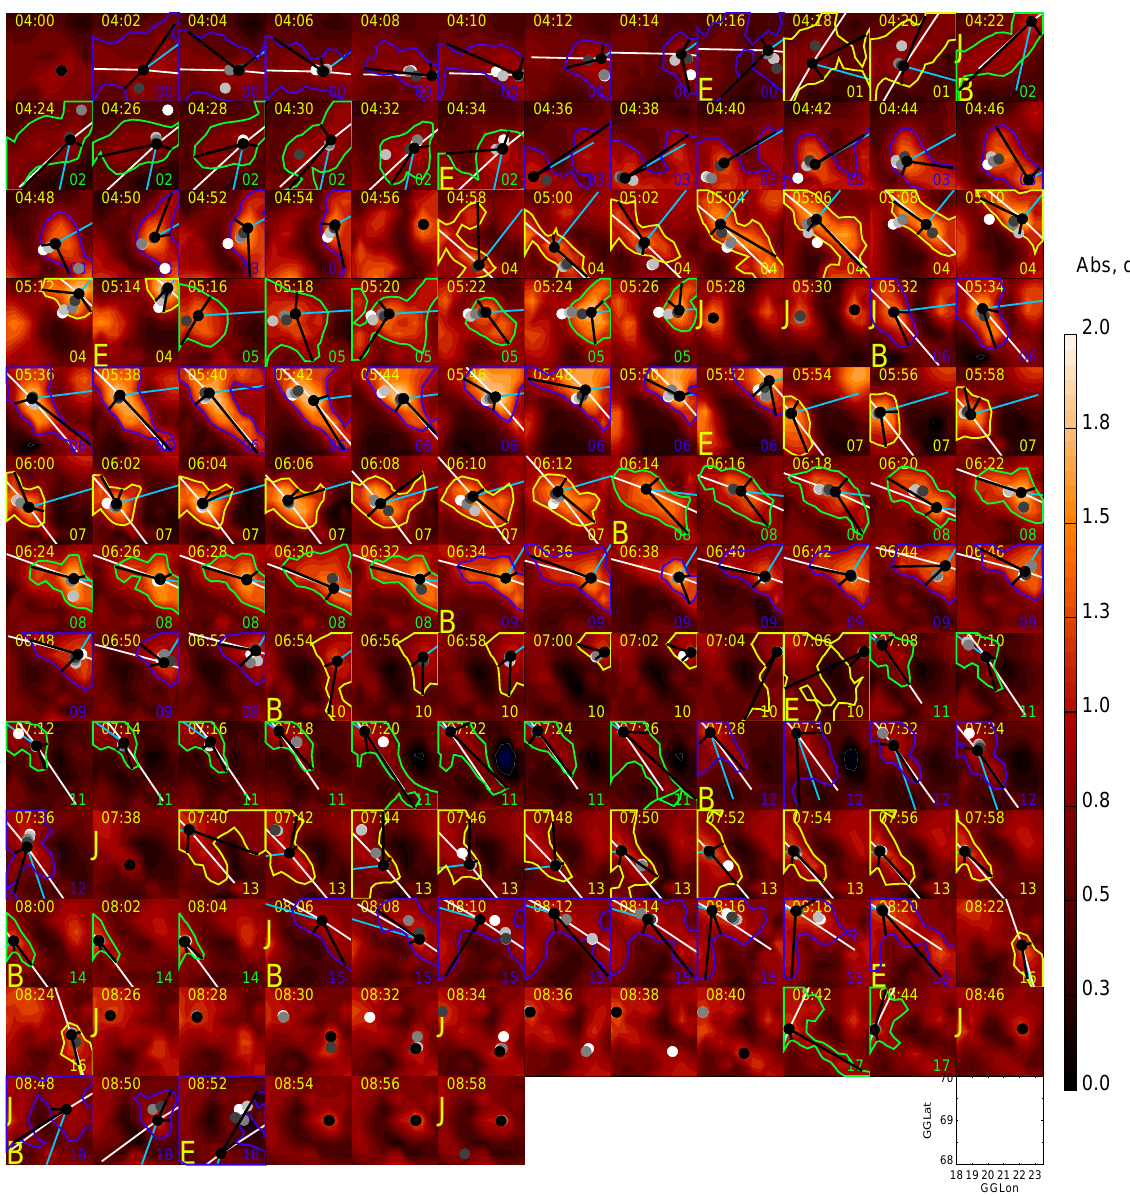
Fig. 1. Sequence of the IRIS absorption intensity images at 1-min resolution for 14 February 2001, 04:00–09:00 UT. The scale for the absorption is indicated on the right. For each frame the absorption maximum position is shown by the large black dot. Coloured contours represent the half-power contours for each individual patch with the patch number indicated in the right bottom corner of each image. The four previous absorption maximum positions (for the same patch) are shown by grey dots, with the lightest dot being the maximum position 4min before the current one. The yellow letter J indicates whether a jump of more than 100km has occurred in the absorption maximum location, and letters B and E indicate the start and the end frame of the individual patch, respectively. The short (long) straight black line with the origin in the black dot shows the shortest (longest) distance between the absorption maximum and the half-power contour. The white straight line indicates the average direction (for individual patches) of the patch’s longest dimension in cases when the standard deviation in this direction was less than 40 ◦ . The blue straight line shows the average motion direction (for each individual patch).